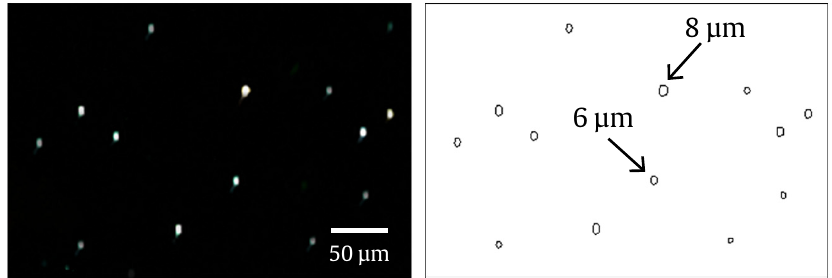
Figure 4. Example of high-speed photography showing diameter and size distribution of the droplets.